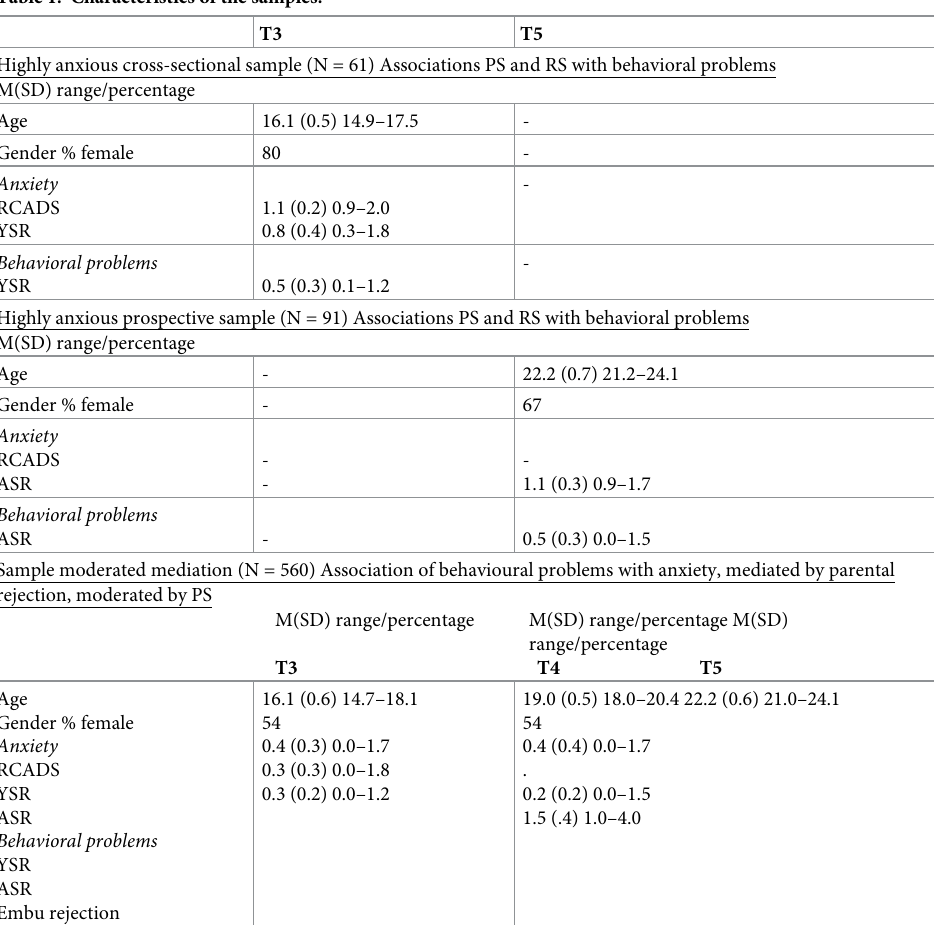
Table 1. Characteristics of the samples.